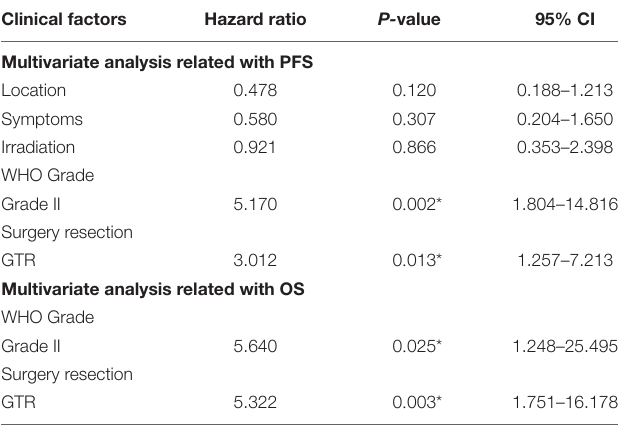
TABLE 5 | Multivariate analysis related with PFS and OS.